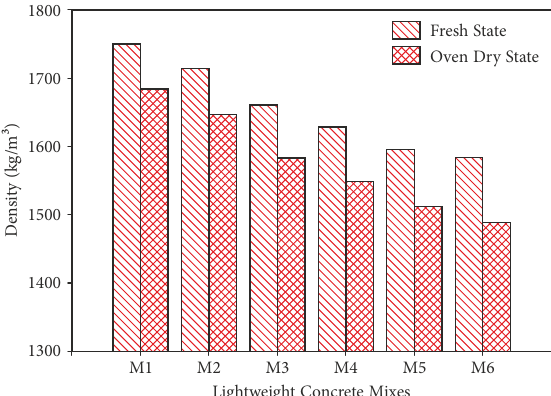
Fig. 2. Fresh and Oven Dry Density of